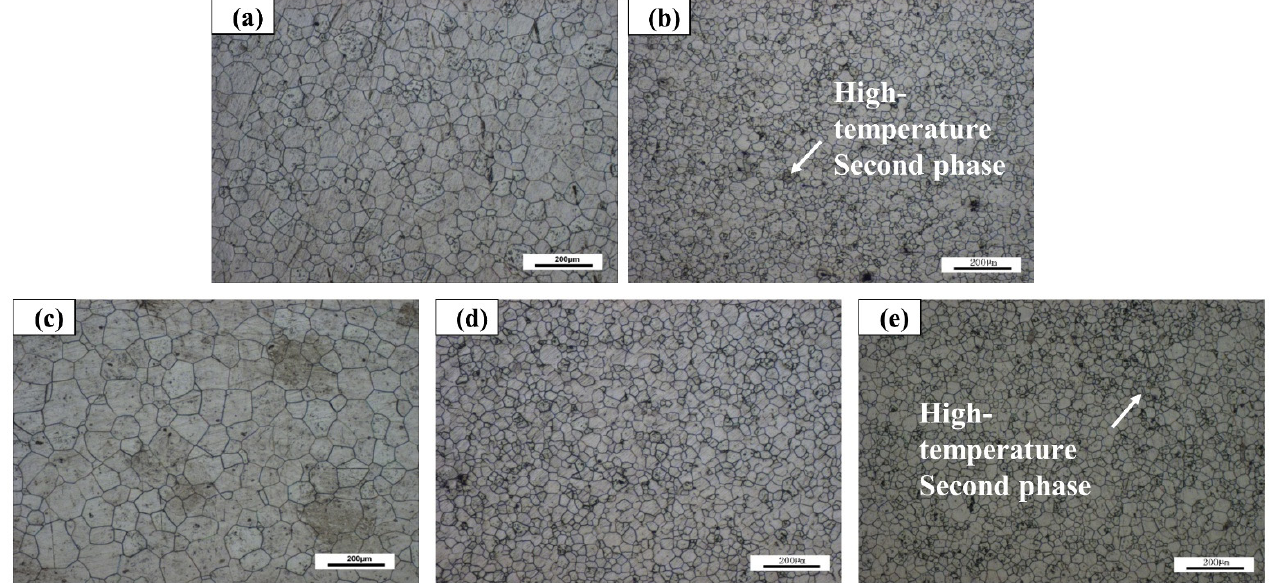
Figure 12. Optical microstructure from the top, middle, bottom of ( a , b ) as-extruded and ( c – e ) aged GWK-a alloy after flammability testing.